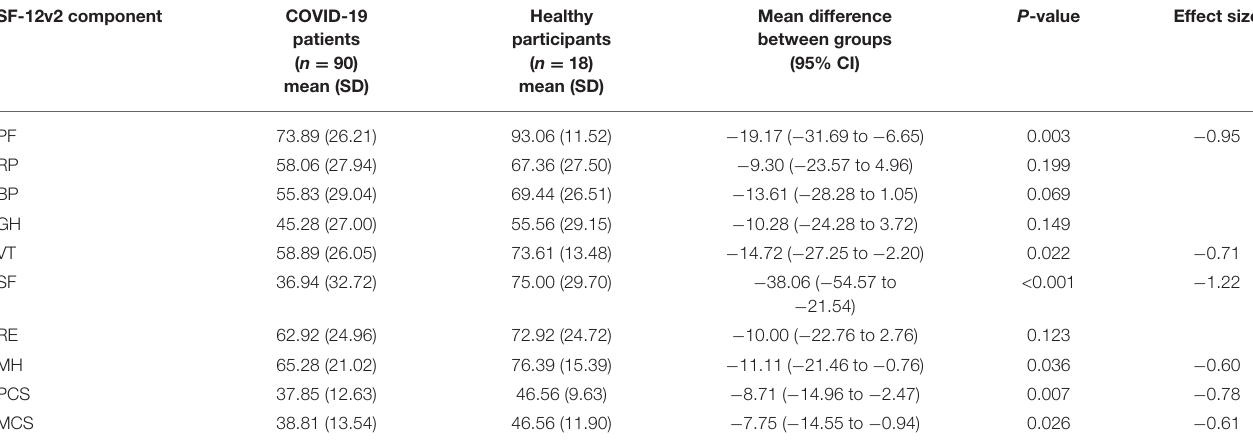
TABLE 8 | Average score of SF-12v2 components reported by COVID-19 survivors and healthy participants. SF-12v2 component